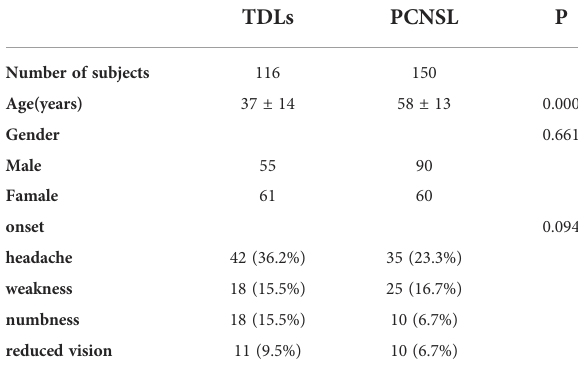
TABLE 2 Statistical between TDL and